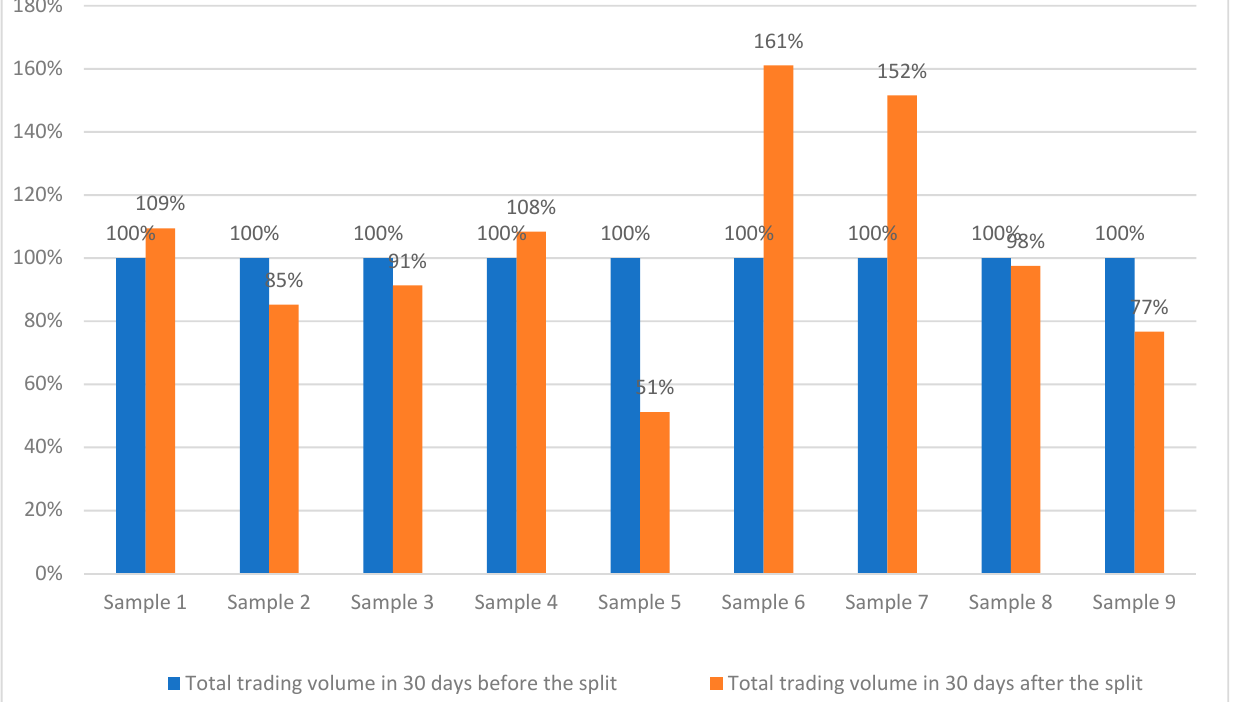
Figure 1. The total trading volume during the 30 days before (left column; blue online) and after (right column; orange online) the split. The total trading volume before the split is treated as benchmark (100%) in order to check the change in the total trading volume after the split.